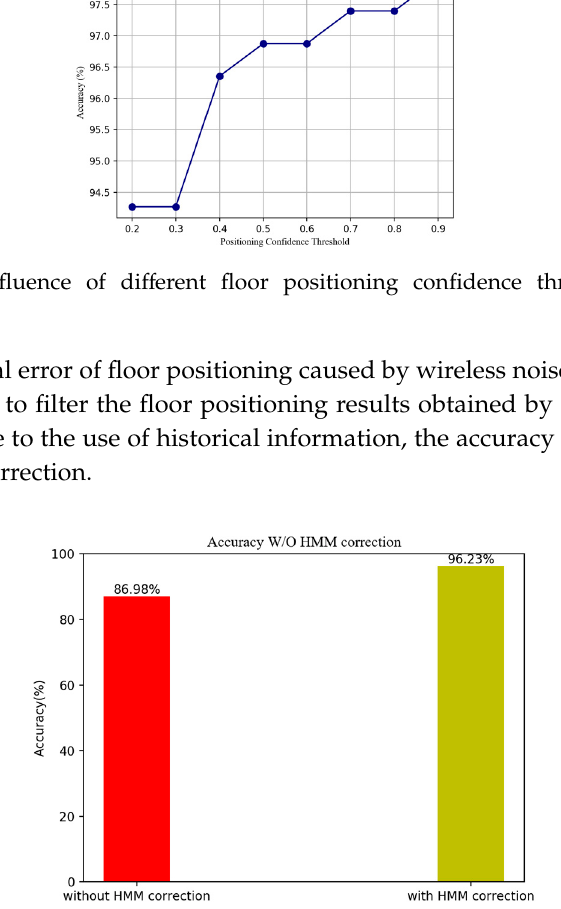
Figure 11. Accuracy without and with HMM correction.